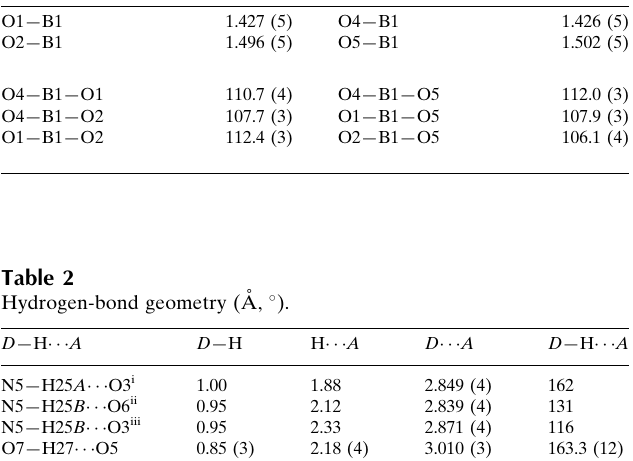
Selected geometric parameters (A˚ , (cid:3) ).